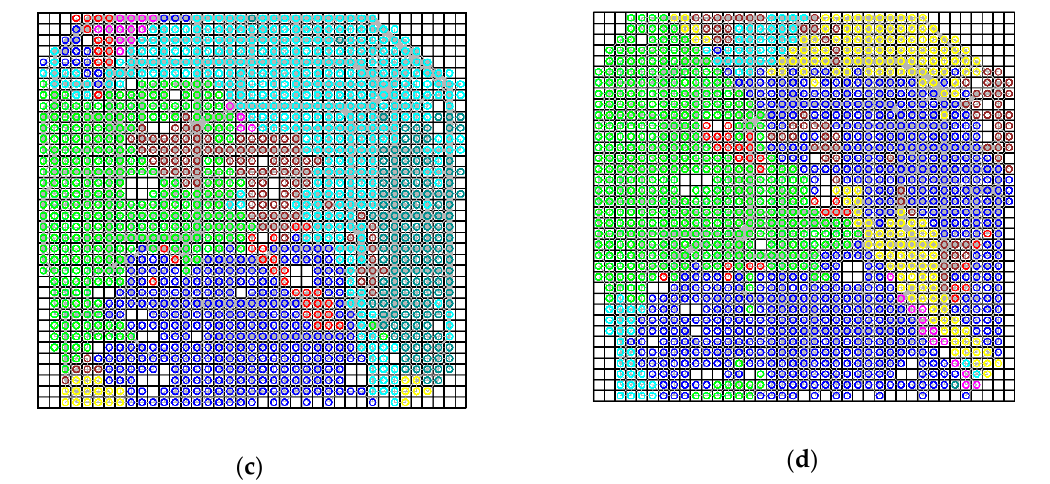
Figure 10. Communities in different time periods with cell size k = 500 m: ( a ) morning rush hour; ( b ) noon rush hour; ( c ) evening rush hour; ( d ) midnight.